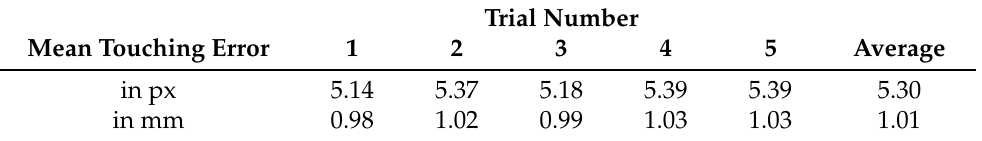
Table 12. Demonstration results after second-stage